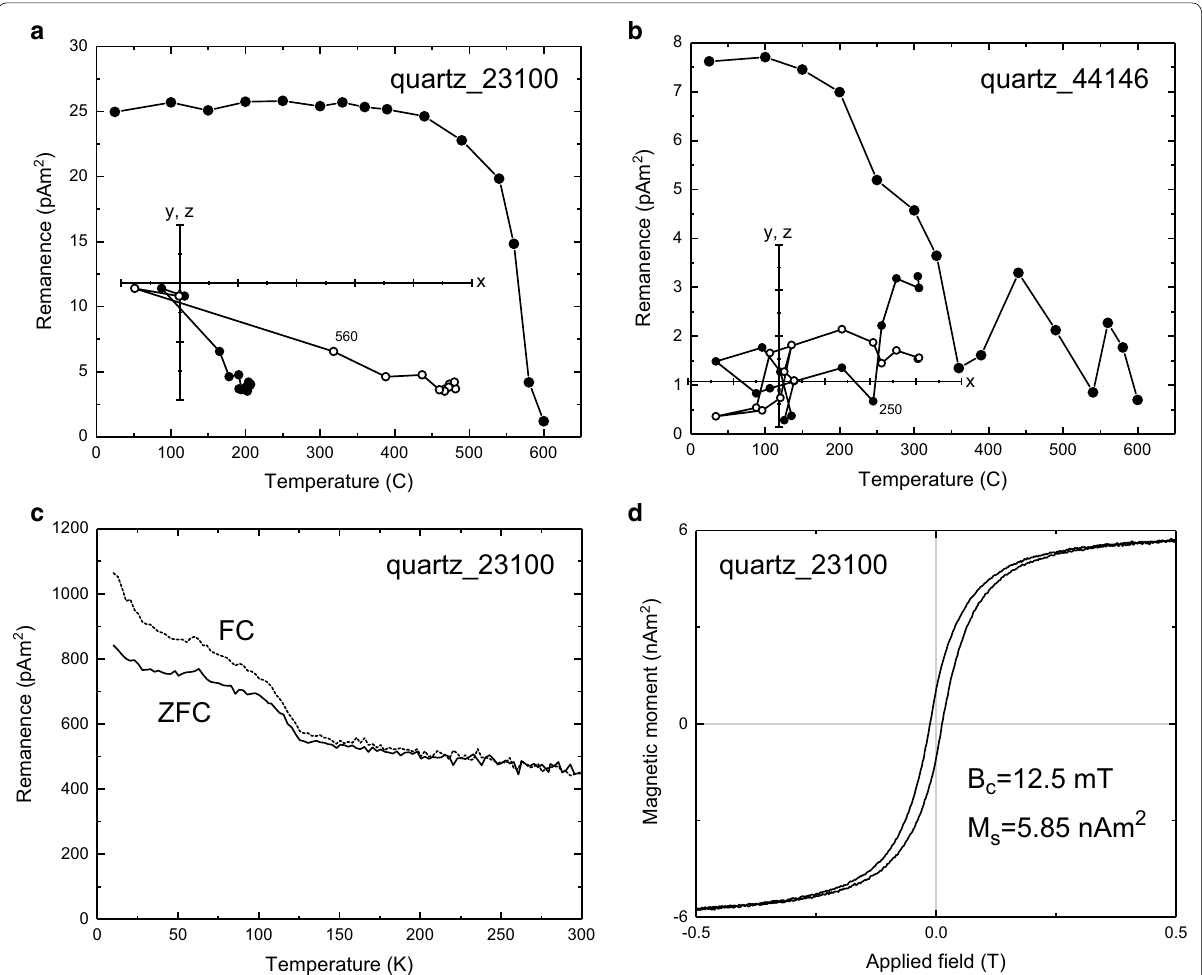
Fig. 5 Results of experiments on selected quartz. a , b Stepwise ThD of NRM. In the orthogonal plot, open and closed circles indicate X – Y and X – Z planes, respectively. c Low-temperature remanence measurements. Solid lines for ZFC measurements and dotted lines for FC measurements. d Hysteresis loop after slope correction. The slope correction coefficient was 74.8 nAm 2 +